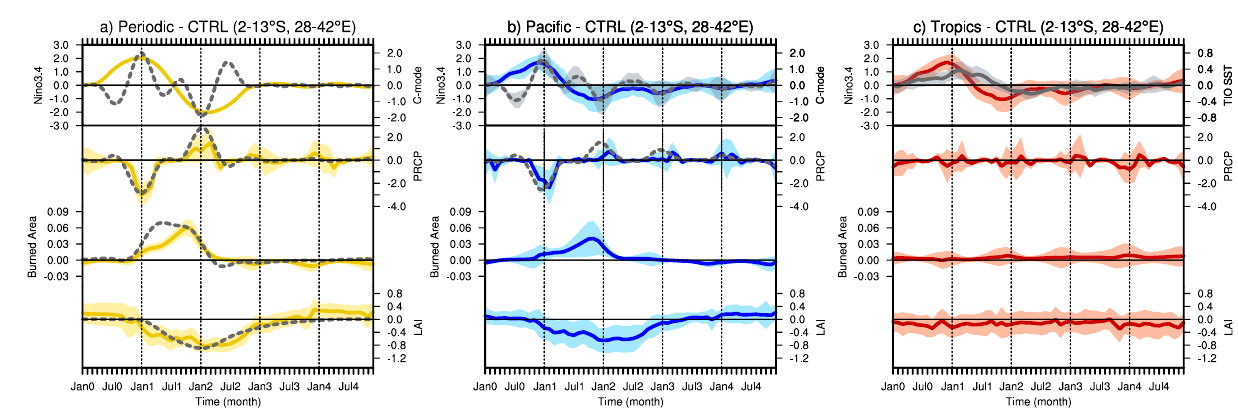
Figure. 3. Composite differences of burned area (unit: %) between El Niño and La Niña events for the Periodic experiment, the Pacific experiment, the Tropics experiment, and the observations for D(0)JF(1) ( a – d ) and SON(1) ( e – h ): El Niño events: 1997, 2002, 2009; La Niña events: 1999, 2000, 2007, 2010 for observations. Stippling indicates a statistically significant difference at the 95% significance level. Fig. 3 was generated using NCAR Command Language Version 6.5.0 (http:// dx. doi. org/ 10. 5065/ D6WD3 XH5).